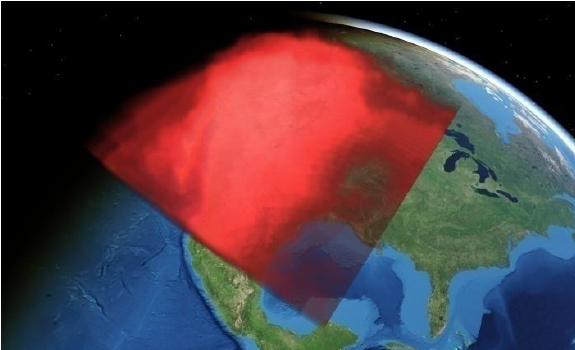
Figure 12 - Volume rendering of air temperature values over North